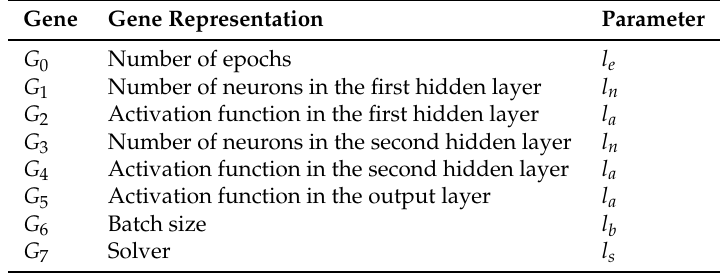
Table 6. Chromosome construction parameters for the case od MLP with two hidden